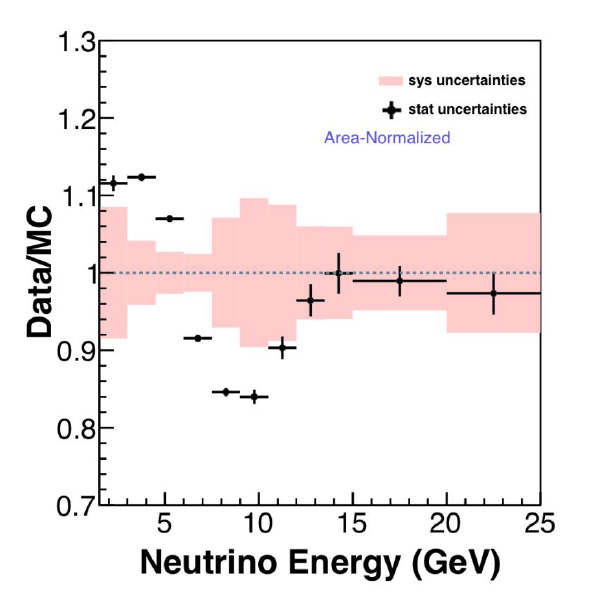
Figure 2. Ratio of the observation to simulation for the reconstructed MINERvA medium-energy NuMI neutrino event spectrum for low energy-transfer events. (This is the updated version of what is shown in